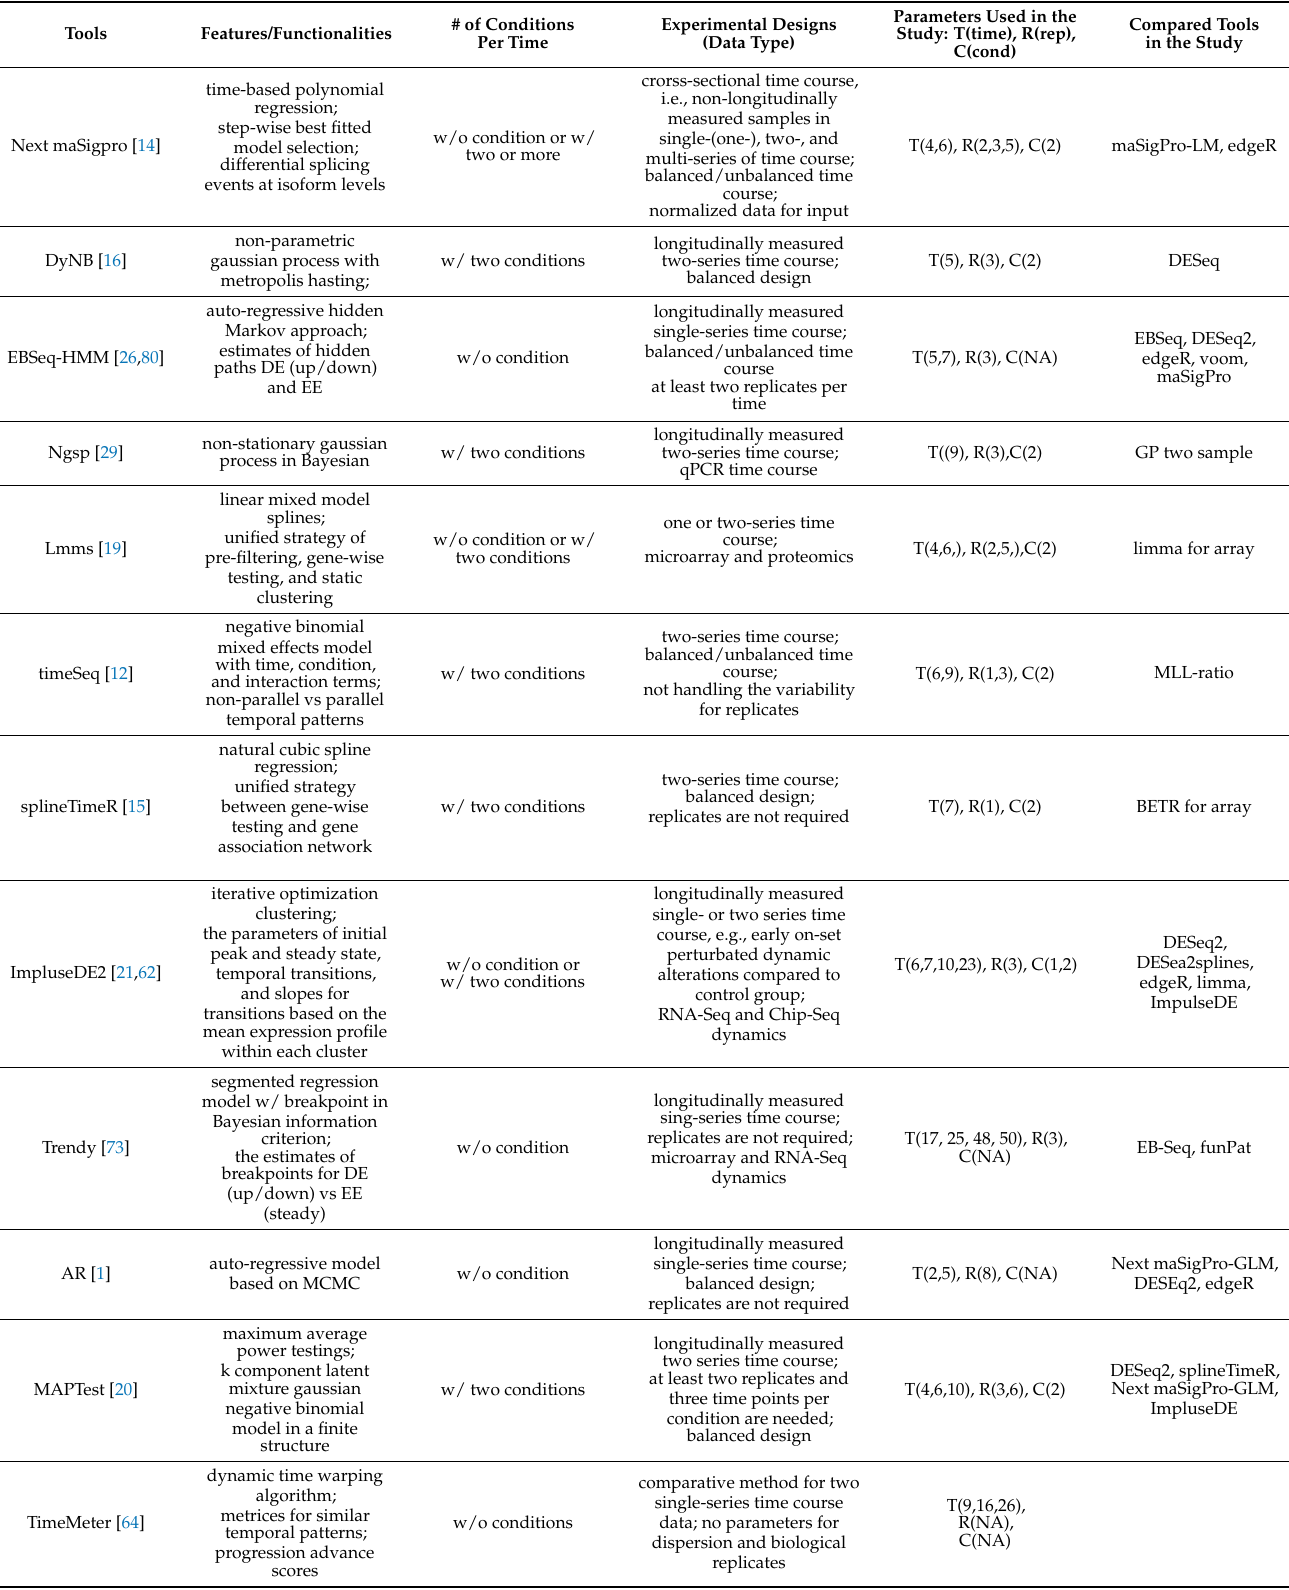
Table 1. Dynamic gene-by-gene (gene-wise) testing tools for non-periodical time course RNA-Seq data.